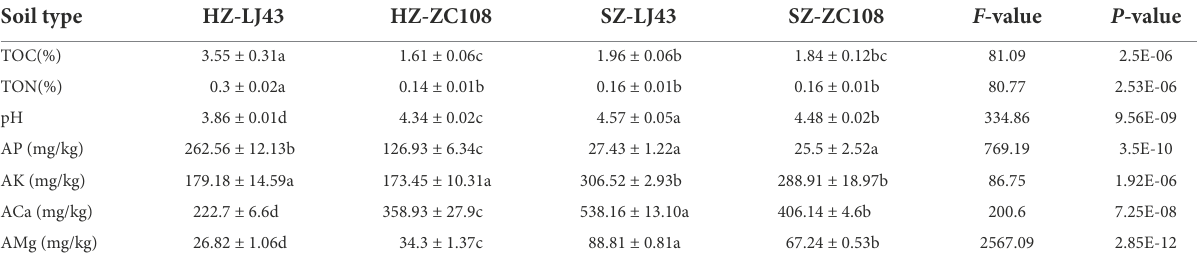
TABLE 1 Contents of some major soil nutrients and soil pH in different tea gardens with different tea varieties.